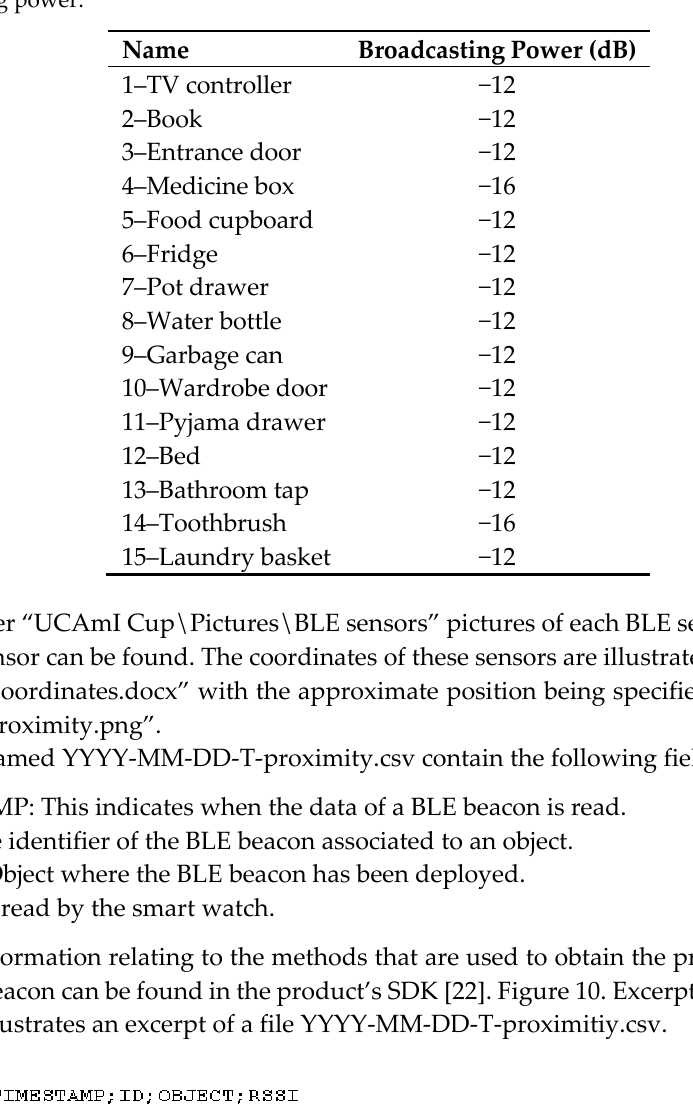
Table 3. Details of the set of BLE sensors deployed in the UJAmI SmartLab and their respective BLE broadcasting power.